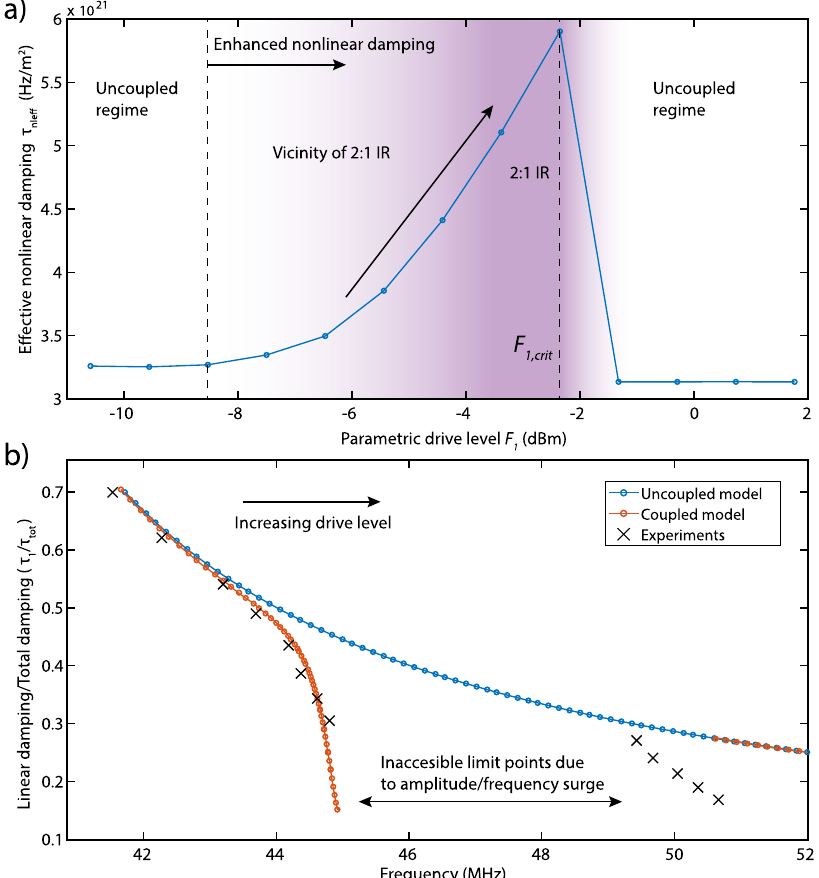
Fig. 3 Measurements and fi ts of the effective nonlinear damping. a Variation of the effective nonlinear damping parameter ( τ nleff ) with respect to parametric drive. The τ nleff is obtained by fi tting the numerically generated curves of Fig. 2a as the fi t parameter. Dashed lines represent different regimes of nonlinear damping. White regions represent a constant nonlinear damping and purple region represents an increase in nonlinear damping in the vicinity of 2:1 IR. b Comparison of the ratio between linear damping ( τ 1 ) and total damping ( τ tot ). In the fi gure, blue and red dashed lines represent τ 1 / τ tot obtained from uncoupled and coupled models, whereas black crosses represent